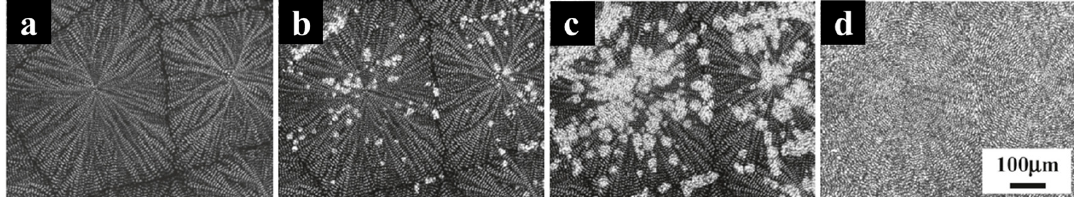
Figure 8. POM micrographs of PVDF/PBS 50/50 blend ( a ) crystallized first at 155 °C and then quenched to 80 °C for ( b ) 0.5, ( c ) 1.5 and ( d ) 20 min for the crystallization of PBS [84]. Copyright 2011. Reproduced with permission from the American Chemical Society.